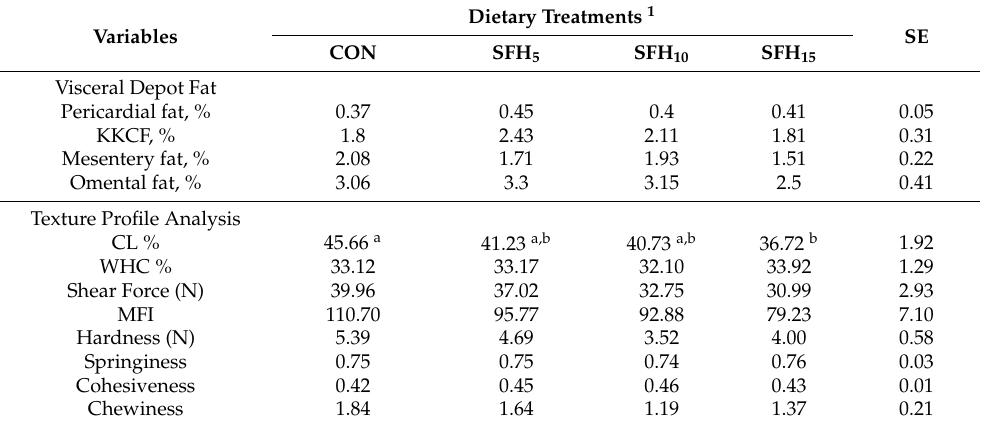
Table 5. Meat quality of growing Awassi lambs fed the experimental diets containing different levels of sunflower hulls.